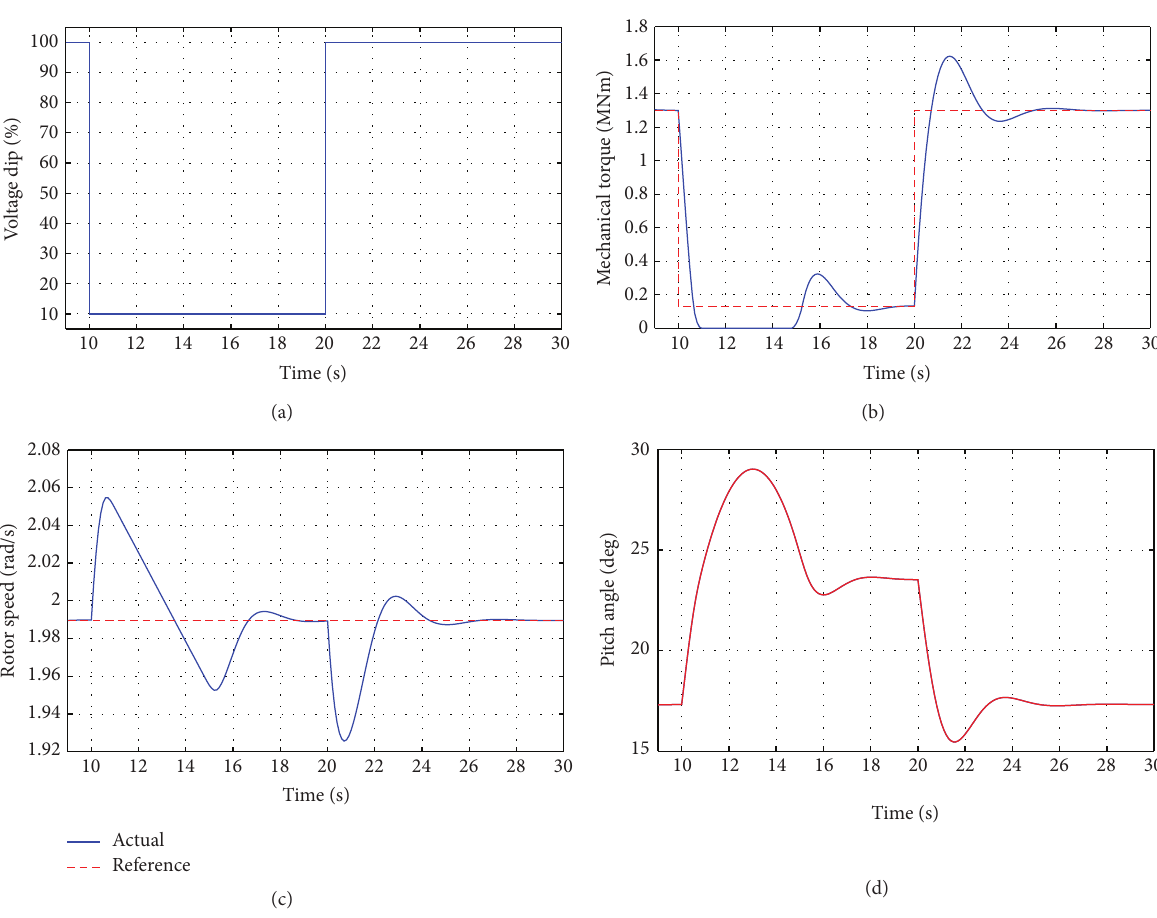
Figure 11: Step response of the pitch regulated WT system when the spinning reserve ability is activated and the power is reduced with 90%: (a) power level, (b) output torque, and (c) rotor speed, (d) pitch angle.